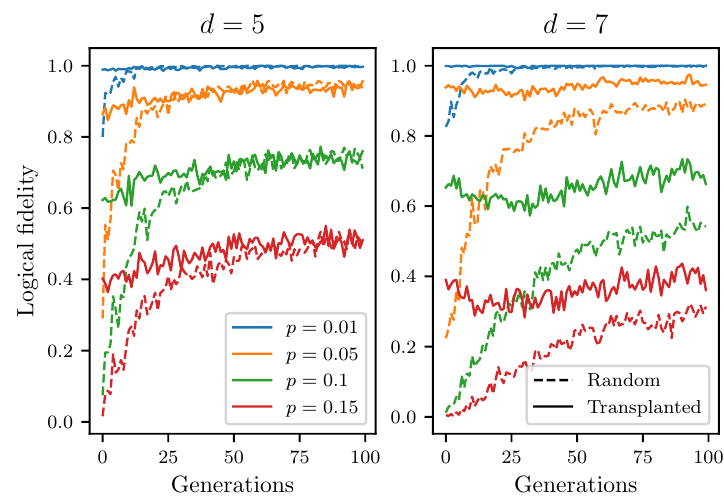
Figure 6: Logical fidelity against training time (measured in number of generations) for the best individual of each generation evaluated on 1000 random syndrome con- figurations at physical error rates p = 0.01,0.05,0.1,0.15. This is a typical training run for the bitflip noise model. The dashed lines correspond to starting the training procedure with an initially random population, while solid lines correspond to start- = 3 decoder ing with a population of transplanted neural-networks from the best d 1 = 5, and the best d = 5 decoder for d = for d 2 1 2